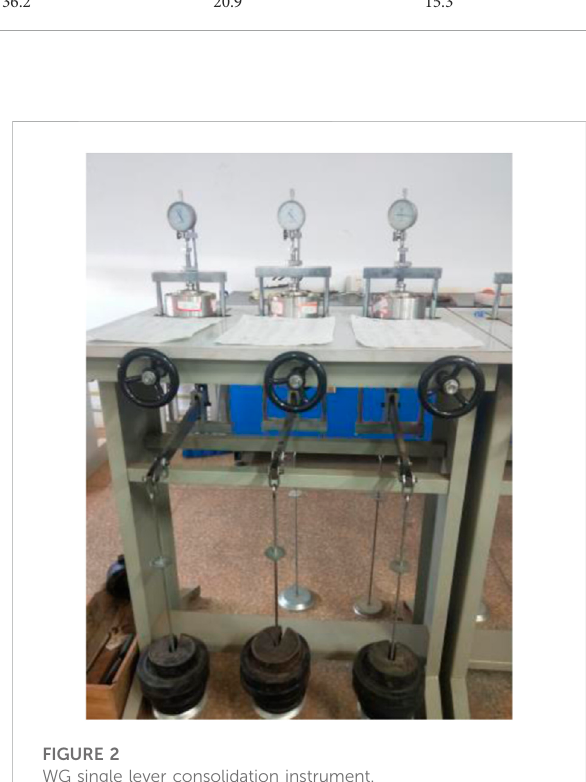
FIGURE 1 Bio-enzyme.